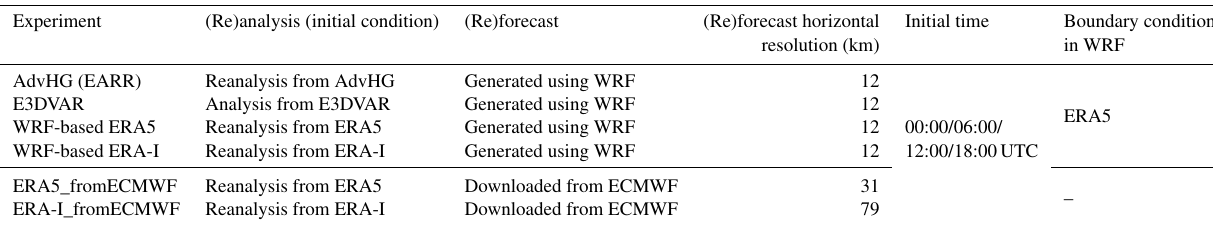
Table 3. (Re)analyses and (re)forecasts with corresponding experiments used in this study. Experiment